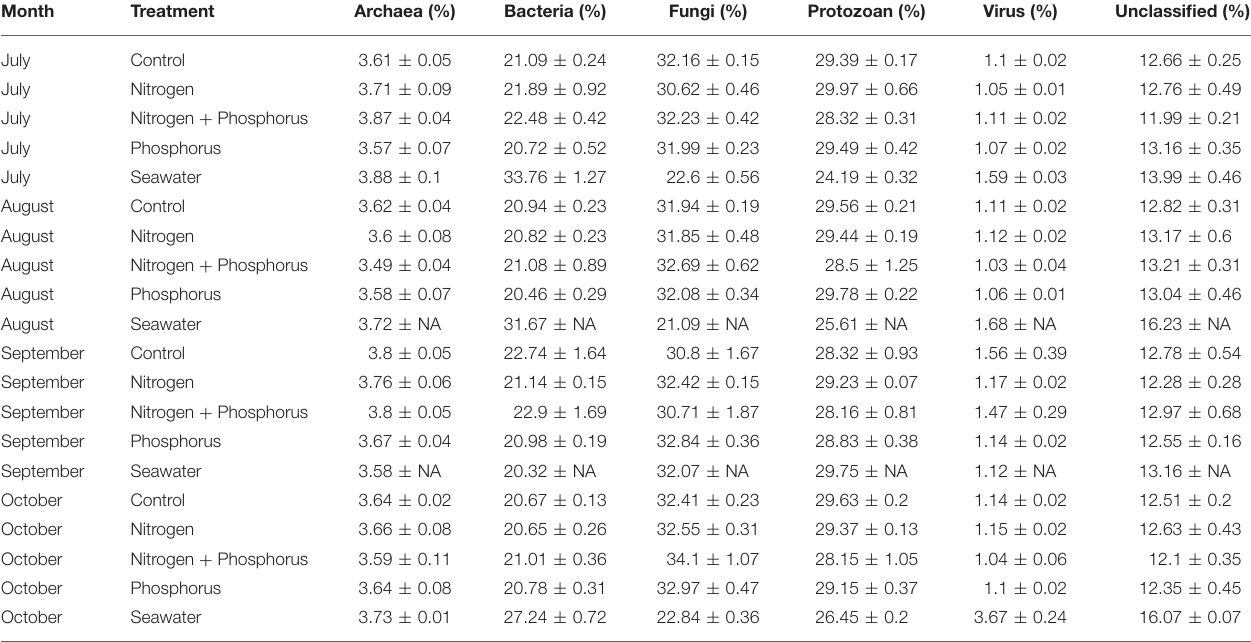
TABLE 1 | Mean relative taxonomic composition and standard error of the mean of different microbial groups identified from Siderastrea siderea coral metagenomes.